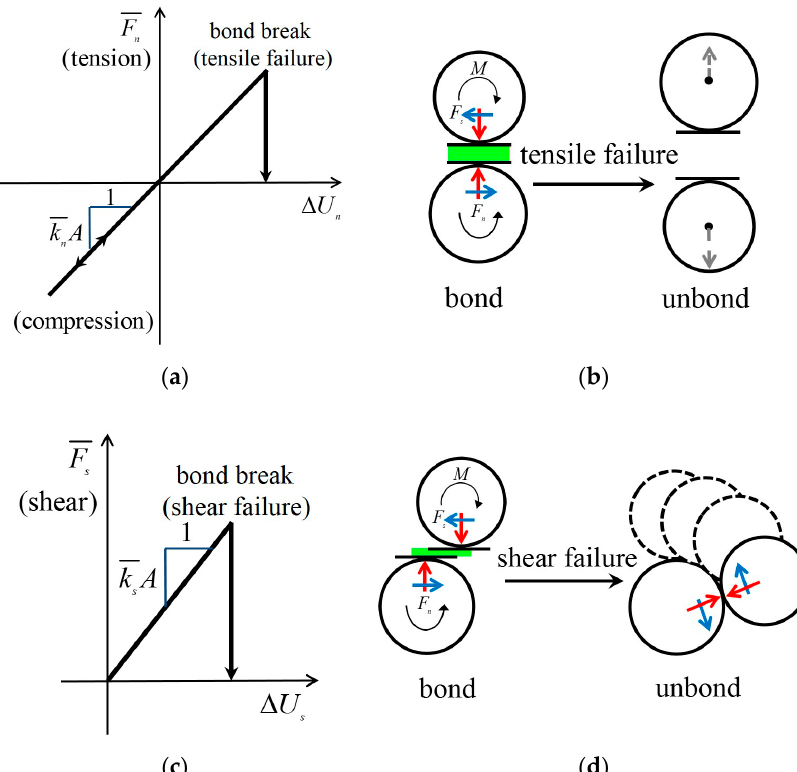
Figure 2. Force-displacement model for the interactions in rock matrix and beddings: ( a ) normal force versus normal displacement relationship; ( b ) tensile failure in matrix; ( c ) shear force versus shear displacement relationship; ( d ) shear failure in matrix (refer to Potyondy and Cundall [37]). Each contact may have two failure modes: tensile failure and shear failure. The failure is σ determined by the stress at the contact point. For the tensile failure, the tensile stress is calculated by pb pb F M R n A I σ β= +